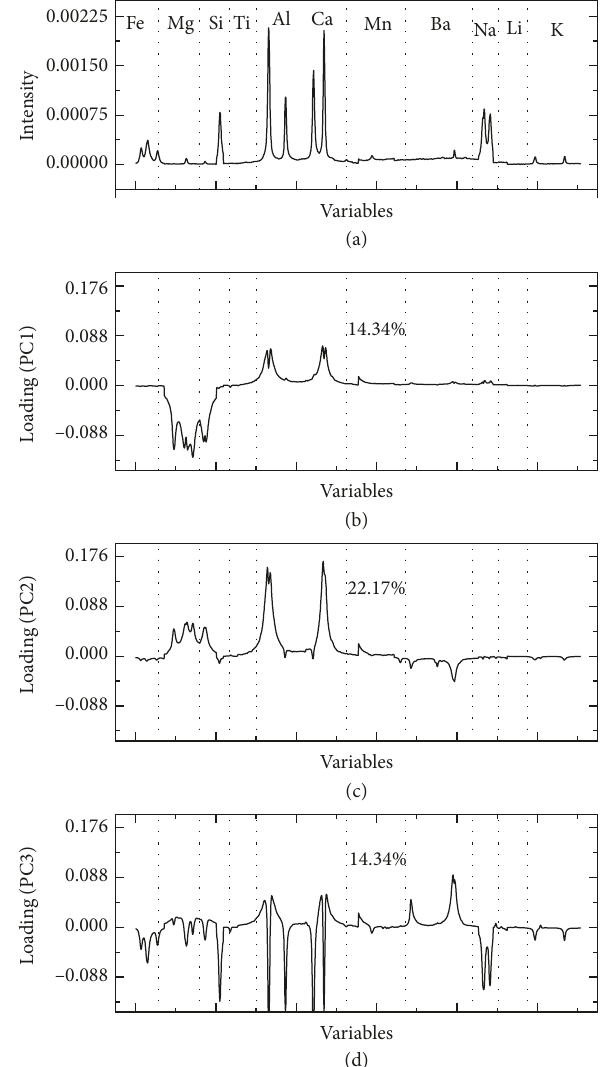
Figure 4: (a) A recombination of selected spectral variables in Table 2 for the tektite sample; (b) PC1 loading plot; (c) PC2 loading plot; (d) PC3 loading plot. Comparison between the PCA loading plots of the first three principal components is shown, the per- centages represent the explained variance for each principal component. These three principal components, combined, explain 65.35% of the net variance in the data set. The loadings were compared to the recombined spectrum in order to observe the variables in the spectrum that contribute to